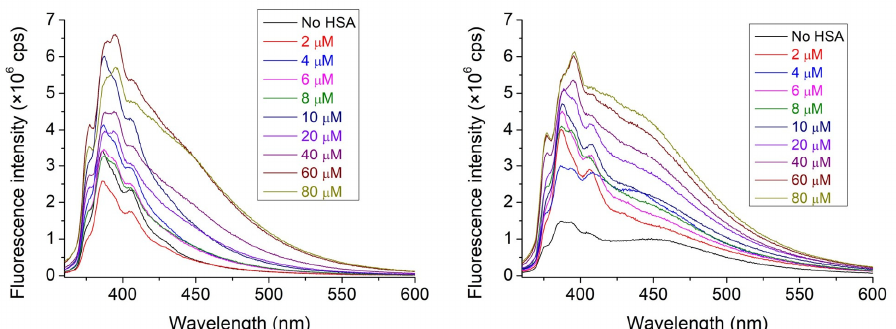
Figure 3. The fluorescence spectra of nitroxide 1 (1 μ M) in the absence and in the presence of HSA with increasing concentrations. Solutions in the absence ( left ) and solutions in the presence ( right ) of cavitand 2 were recorded. The concentration of cavitand 2 was set to 9.375 μ M. However, this anomaly also introduces the probability of the nitroxide unpaired